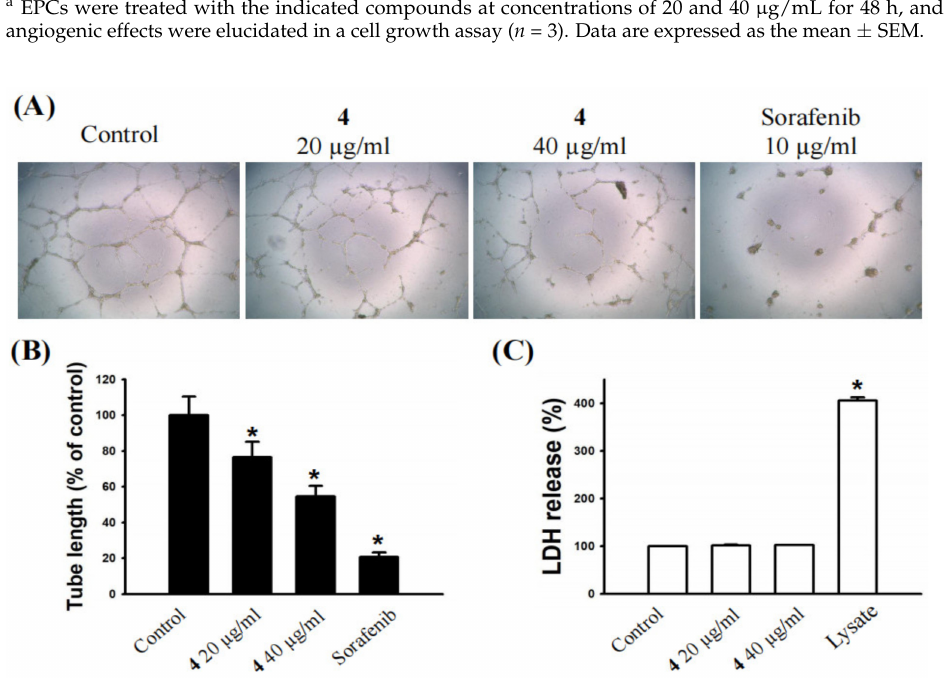
Figure 4. Effects of penisterine D ( 4 ) on tube formation and cytotoxicity of human EPCs. Cells were treated with the indicated concentrations of penisterine D and sorafenib for 24 h. ( A ) The inverted phase-contrast microscope was utilized for recording tubular morphogenesis. ( B ) The tube formation of EPCs was quantified by measuring the length of tubes by Image-J. ( C ) Cells were treated with 4 for 24 h and cytotoxicity was determined using the LDH assay. Data represent the mean ± SEM. * p < 0.05, compared with the control